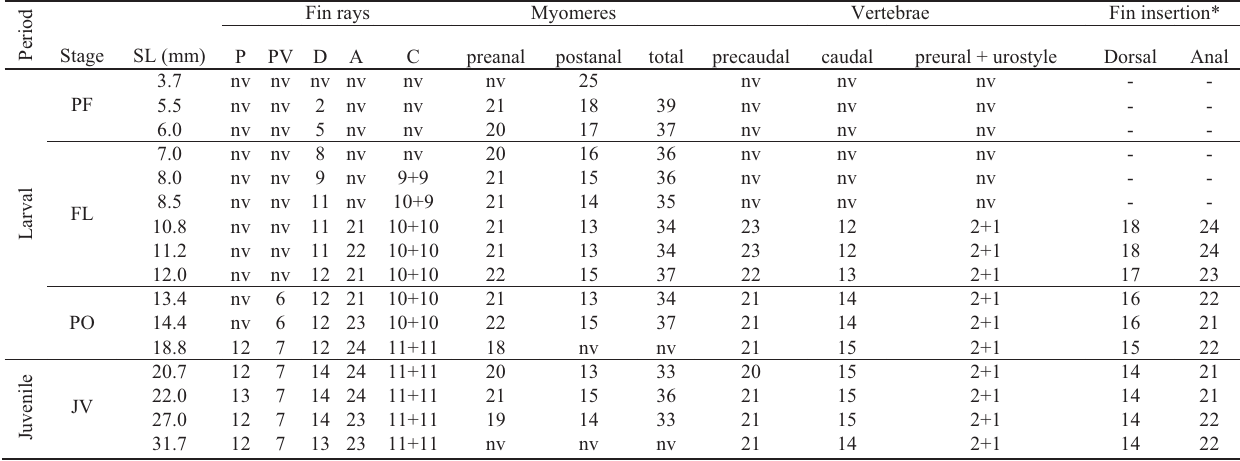
Table 3. Meristic data for preflexion (PF), flexion (FL), postflexion (PO) larvae and juveniles of Anchoviella vaillanti . Fins: pectoral (P), pelvic (PV), dorsal (D), anal (A) and caudal (C). nv - not visible. *in relation to precaudal